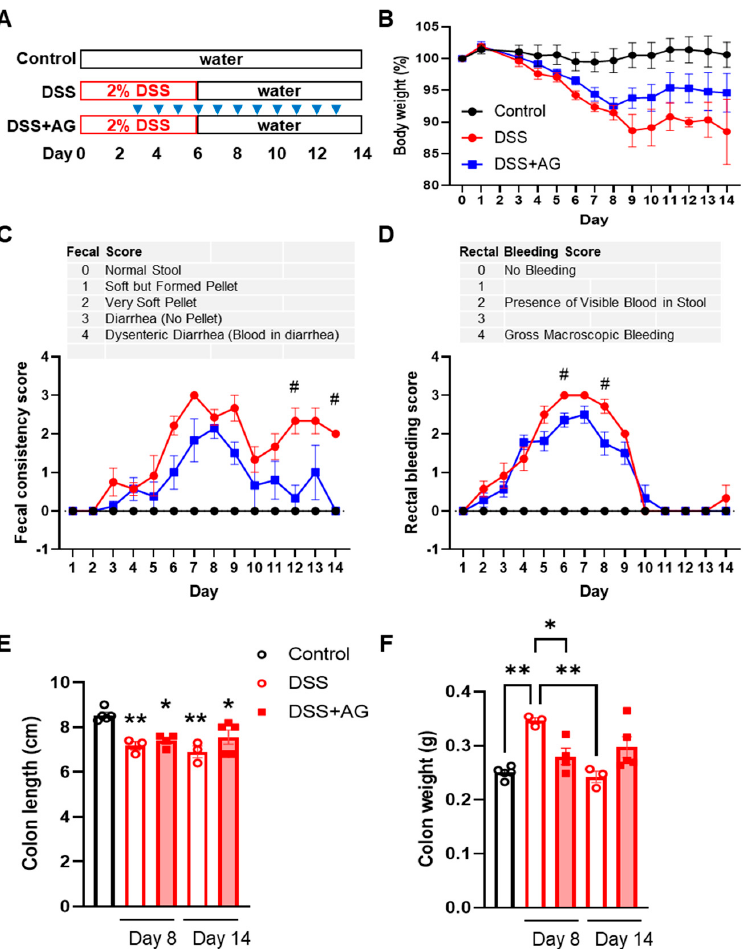
Figure 1. Ghrelin alleviates DSS-induced colitis in 16-18 months-old female mice. Normal or 2% DSS in drinking water was given to mice for 6 days, then switched to normal drinking water until day 14. Mice in DSS + AG group were intraperitoneally injected with ghrelin daily from days 3–13, indicated by blue arrowheads ( A ). Disease activities were monitored, including body weight ( B ), stool consistency ( C ) and rectal bleeding ( D ). Mice were euthanized on day 8 and day 14 after assessing disease activities and their colons dissected, length ( E ) and weight ( F ) measured. For ( B – D ), data were analyzed with two-way ANOVA with a mixed model (treatment group × time) followed by Tukey’s post-hoc tests. For ( E , F ), data were analyzed with one-way ANOVA (treatment) followed by Tukey’s post-hoc tests. * p < 0.05, ** p < 0.01, compared to control in E, or as